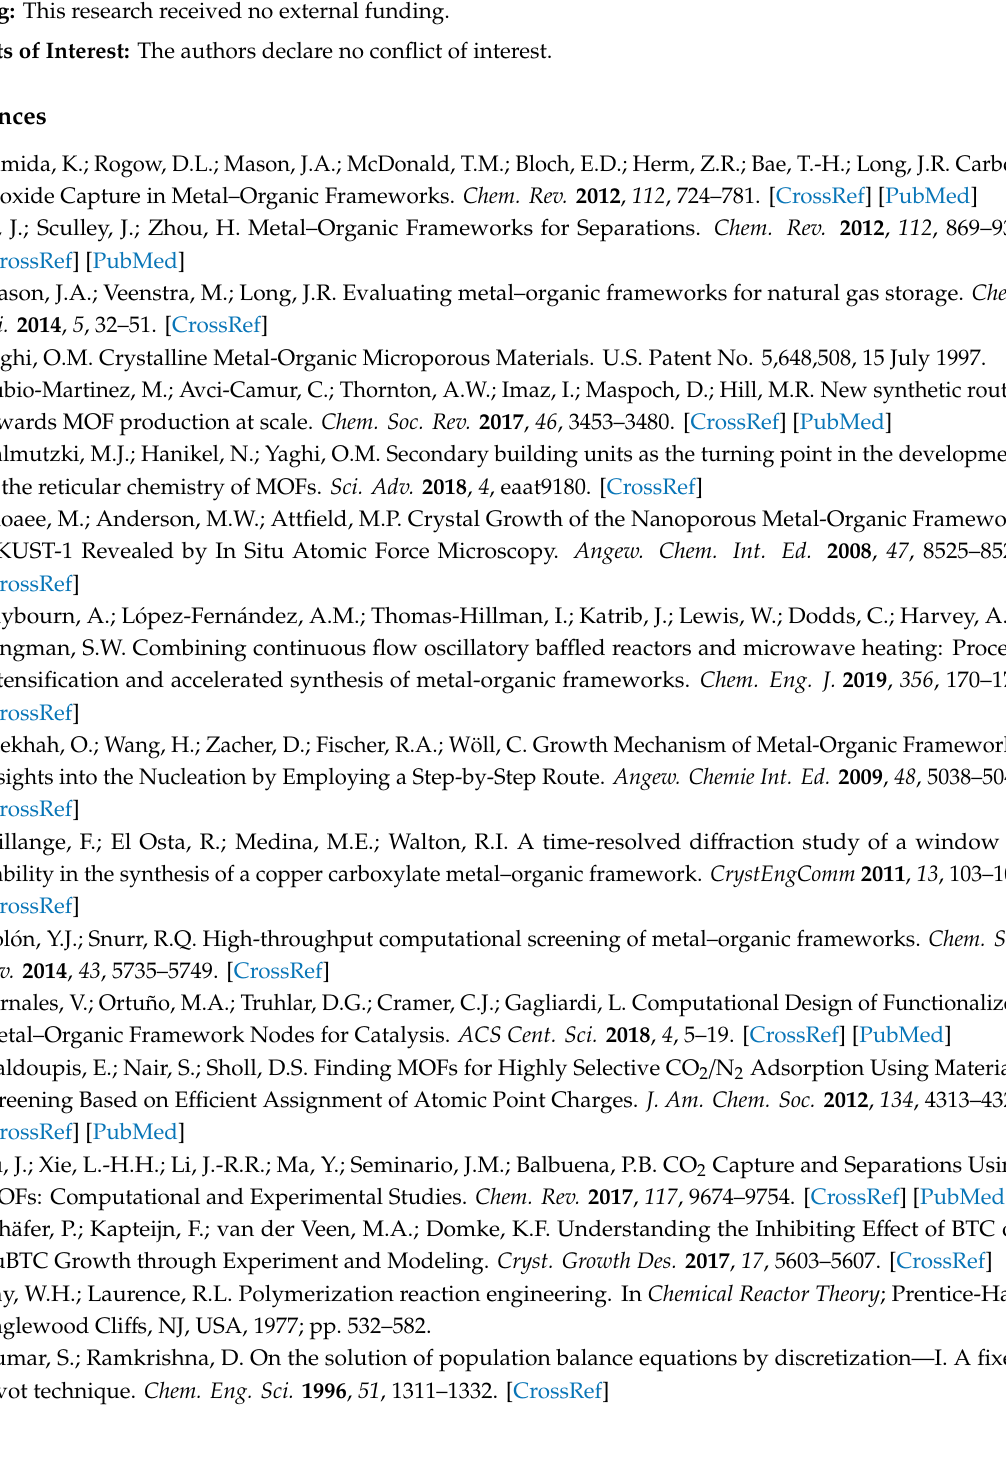
Figure S1: Supersaturation depletion as a function of time for di ff erent rate constants and di ff erent initial saturation ratios in case of no concurrent crystallization. Figure S2: Supersaturation depletion as a function of time for di ff erent rate constants and di ff erent initial saturation ratios in case of concurrent crystallization. Figure S3: Needle-like morphology of BTC crystals with h -vectors. Section S3: General model considering simultaneous oligomerization, crystallization of linkers, and aggregation of